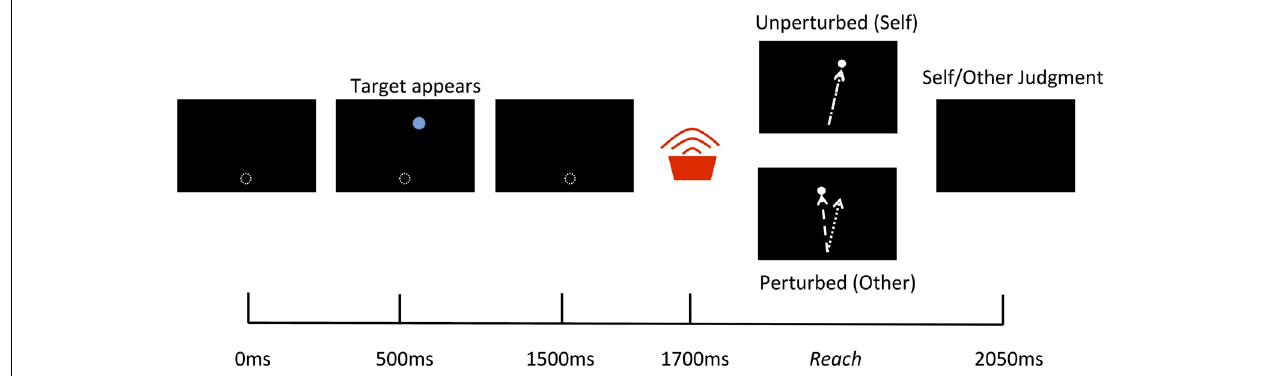
representation of the actual movement ( Self ) or had a spatial perturbation applied ( Other ). At the end of the reach participants were required to give a verbal forced choice judgment as to whether the observed movement was that of Self or Other.